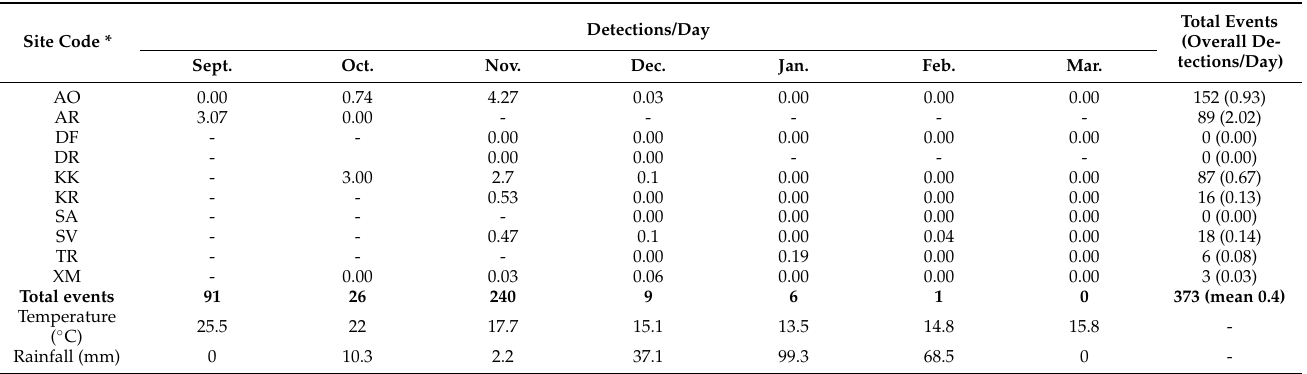
Table 3. Monthly and overall (study duration) independent mouflon detections per survey day for each monitored water trough (dashes denote months when water troughs were not monitored). Monthly daily mean temperature and total monthly rainfall during the study period are also provided.